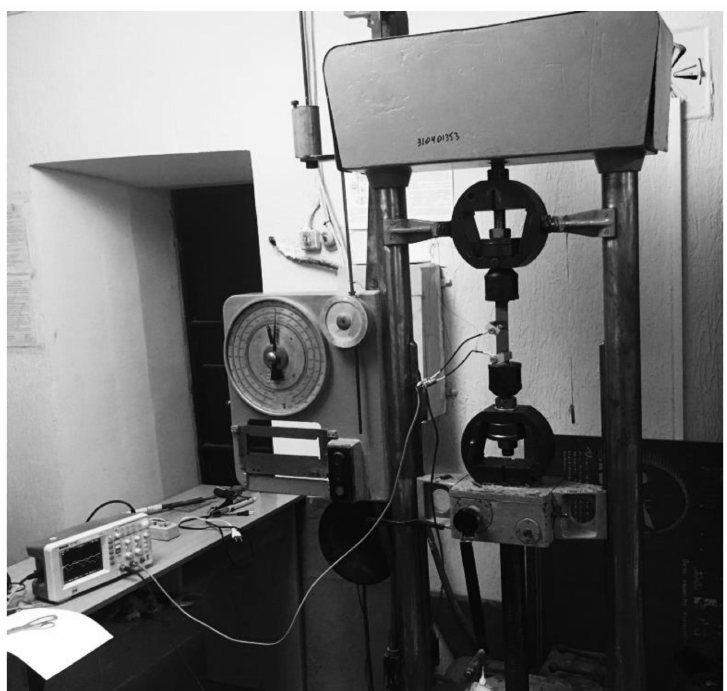
Figure 1. The experimental device for the synchronous measurement of AE signals with uniaxial loading